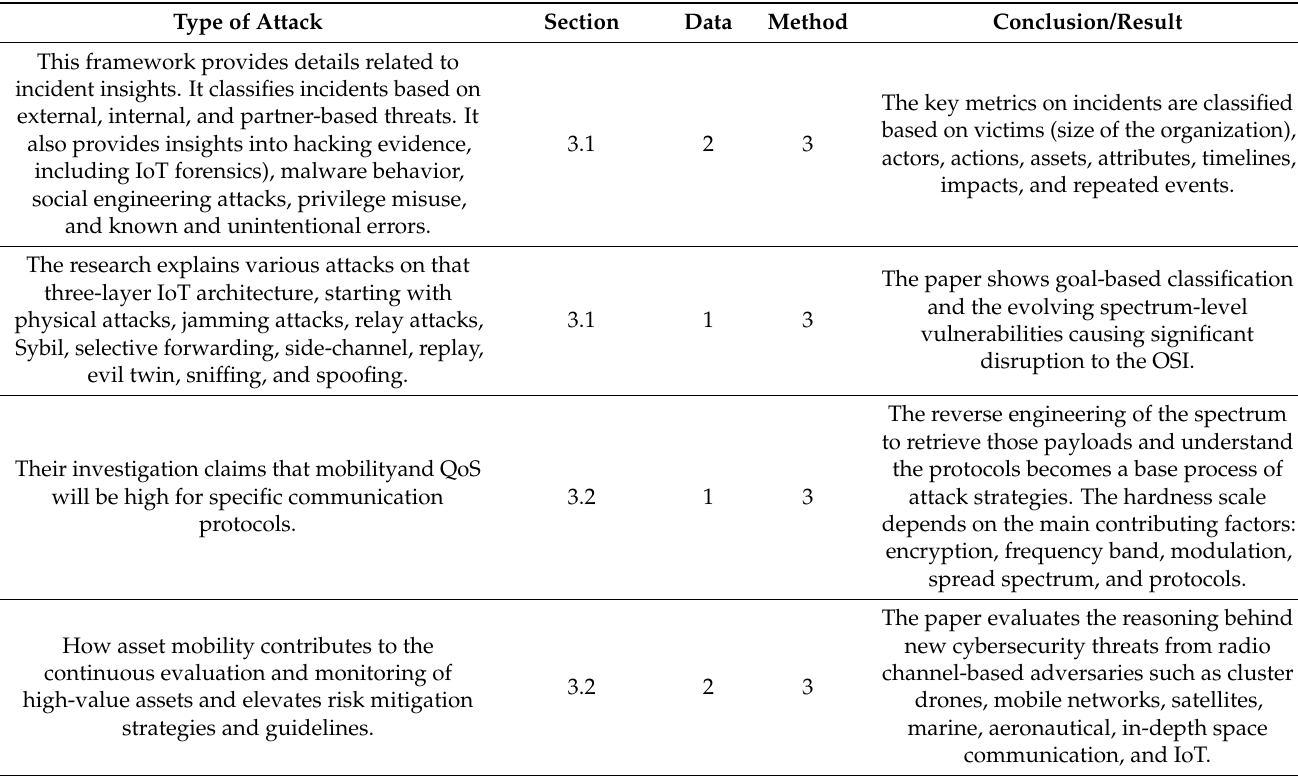
Table 3. Summary of